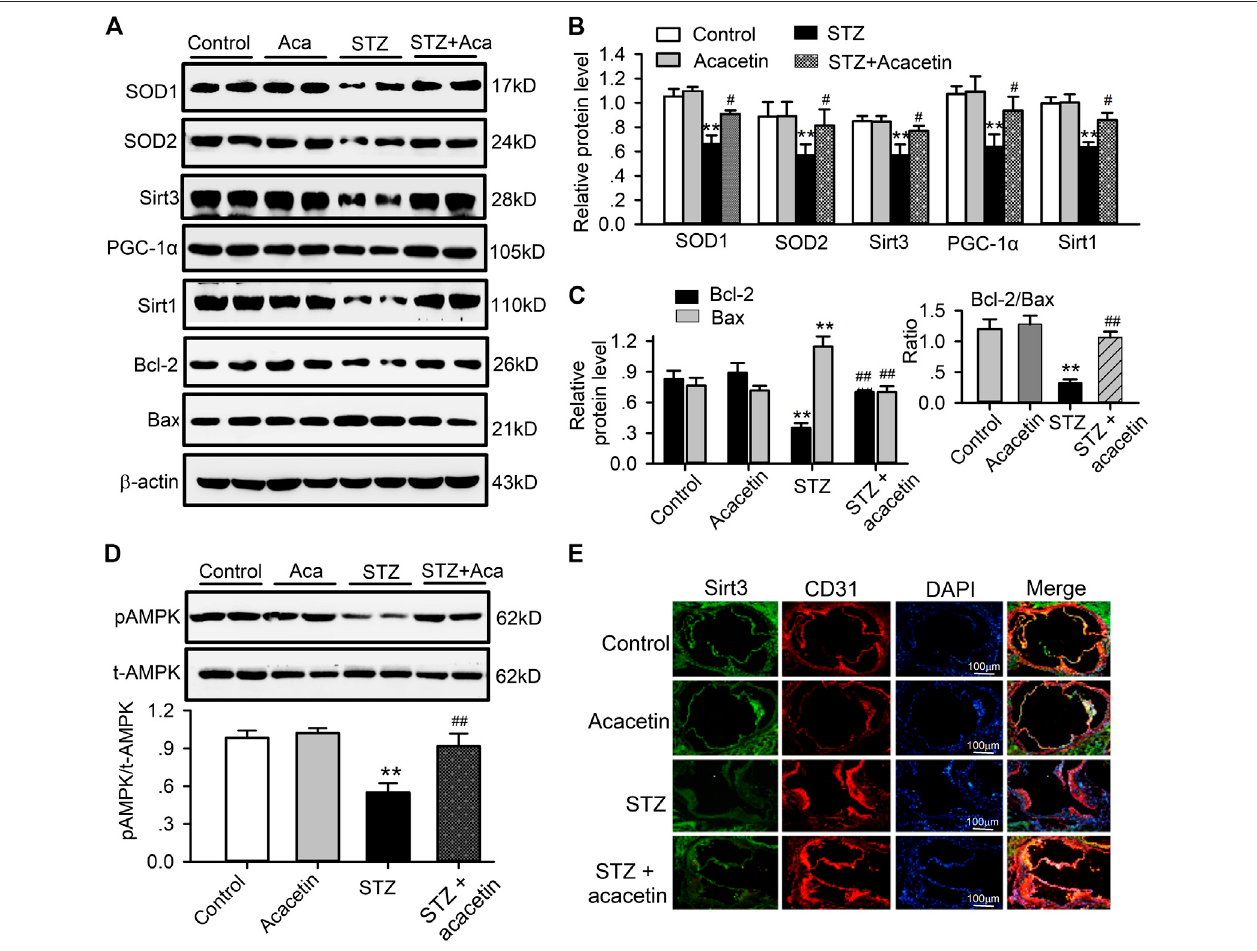
FIGURE 8 | Alterations of related proteins in aortic tissues of STZ-diabetic ApoE − / − mice. (A) Western blots of SOD1, SOD2, Sirt3, PGC-1 α , Sirt1, Bcl-2, Bax, and β -actin in control aorta with and without acacetin and in STZ-diabetic ApoE − / − mice aorta with and without acacetin. (B) Analysis of SOD1, SOD2, Sirt3, PGC-1 α , and Sirt1 (relative to β -actin). (C) Analysis of Bcl-2 and Bax proteins, relative to β -actin. Inset: ratio of Bcl-2/Bax. (D) Western blots of pAMPK and t-AMPK (total AMPK) and relativelevelofpAMPK/t-AMPK. n (cid:2) 6,* p < 0.05,** p < 0.01vs.controloracacetin; # p < 0.05, ## p < 0.01vs.STZ. (E) Sirt3andCD31immunohistochemicalstaining of aortic root section from mice of control, with acacetin, STZ, and STZ with acacetin treatment ( × 10 magni fi cation).